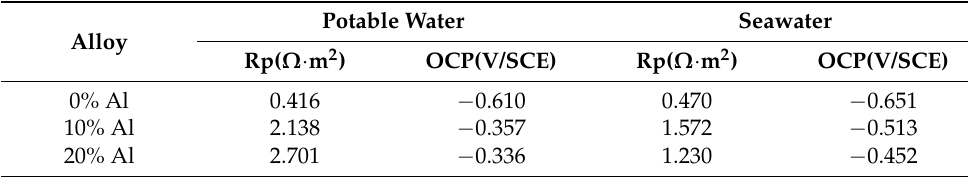
Table 4. Comparison of Mn–Al alloys corrosion properties.